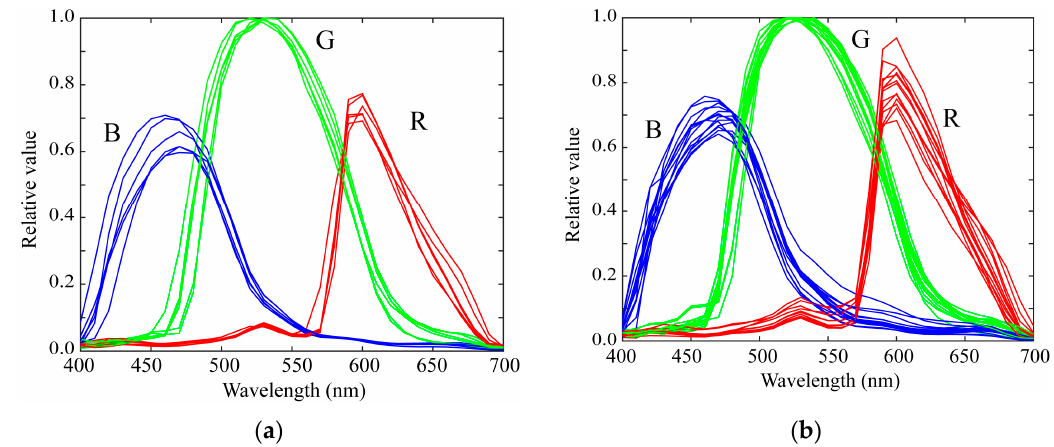
Figure 4. Spectral sensitivity functions classified into the two categories of ( a ) iOS phone cameras, and ( b ) Android phone cameras.